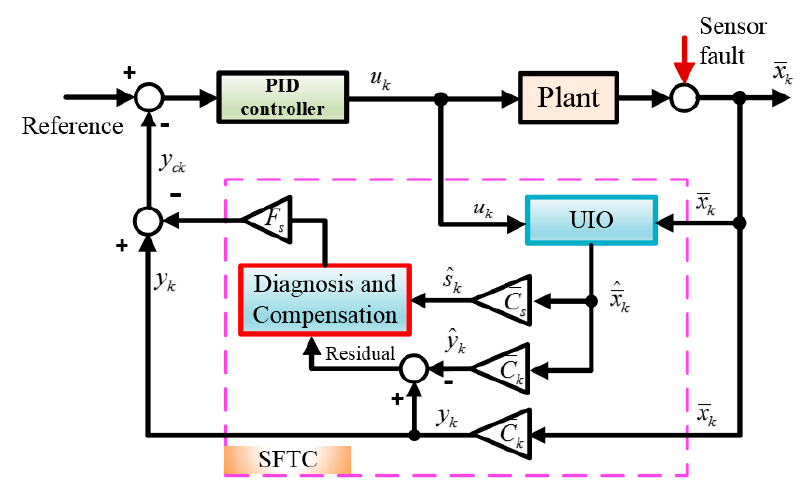
Figure 2. The structure of observer-based fault-tolerant control.